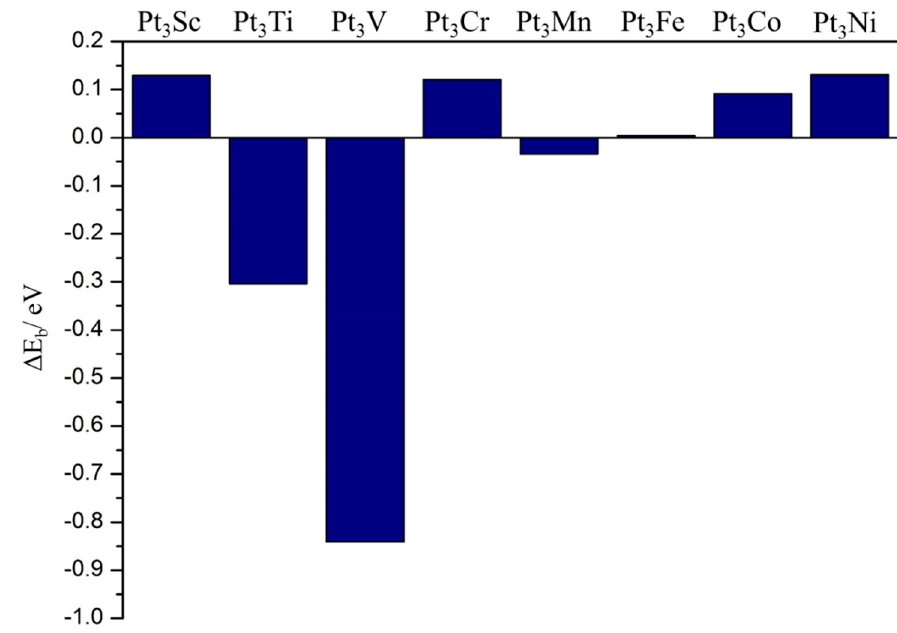
Figure 1. Net binding energy of Pt 3 M on O-doped graphene (OG) with respect to Pt 4 on OG.